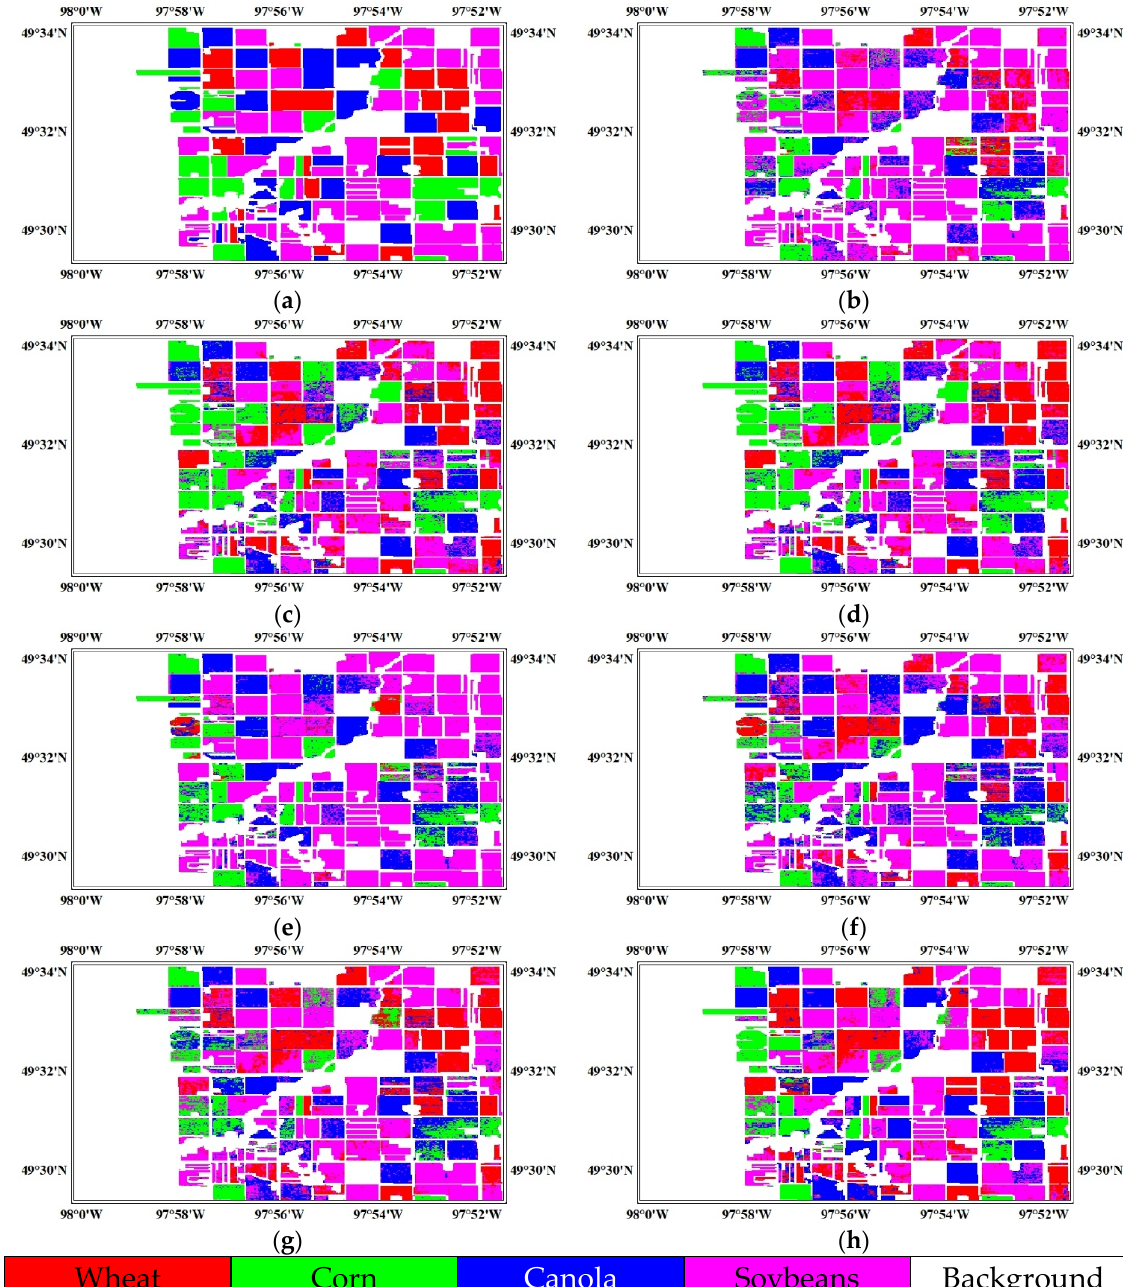
Figure 5. Ground truth map and classification maps in Winnipeg (SD: C -> TD: A), generated by different methods: ( a ) Ground truth; ( b ) DAC; ( c ) TCA+DAC; ( d ) SSTCA+DAC; ( e ) MIDA+DAC; ( f ) SMIDA+DAC; ( g ) SMbDA+DAC; ( h ) WSMbDA+DAC.